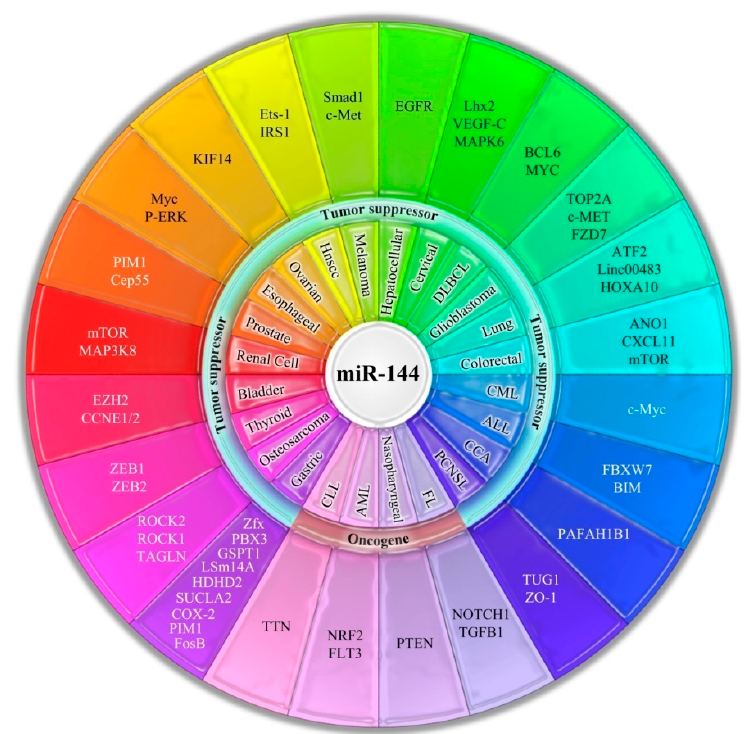
Figure 2. The critical role of miR-144 in different types of cancers. MicroRNAs (miRNAs) are a class of non-coding RNAs that play important roles in regulating gene expression in cancer patients. By targeting specific genes, MiR-144 acts as a tumor suppressor or oncogene. Mostly it downregulated in many types of cancers (see text for detail information). Abbreviations: Diffuse large B-cell lymphoma (DLBCL), Chronic myeloid leukemia (CML), Acute lymphoblastic leukemia (ALL), Cholangiocarcinoma (CCA), Primary central nervous system lymphoma (PCNSL), Follicular lymphoma (FL), Acute myeloid leukemia (AML), and Chronic lymphocytic leukemia (CLL).